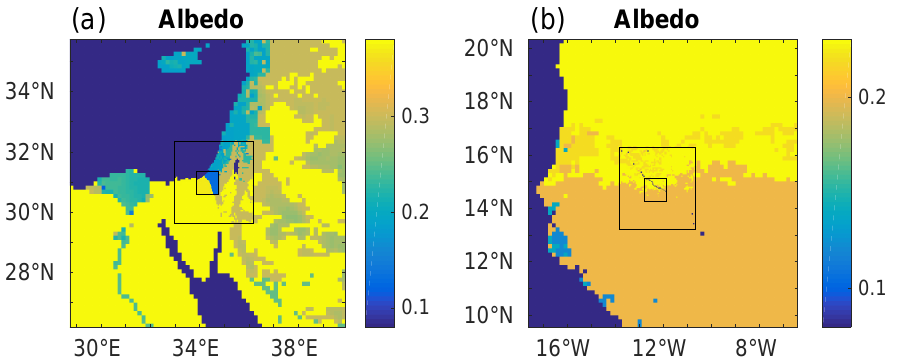
Figure 1. ( a ) The surface albedo of the eastern Mediterranean region. This is the coarser grid region Figure 1. (a) The surface albedo over the eastern Mediterranean region. This is the coarser grid region that was used in the Weather Research and Forecasting (WRF) simulation, whereas the other two that was used in the WRF simulation, whereas the other two finer inner grids are indicated by the inner finer inner grids are indicated by the inner black rectangles; ( b ) Same as ( a ) for the second WRF run, black rectangles. (b) Same as (a) for the second WRF run, over the Sahara/Sahel region. over the Sahara/Sahel